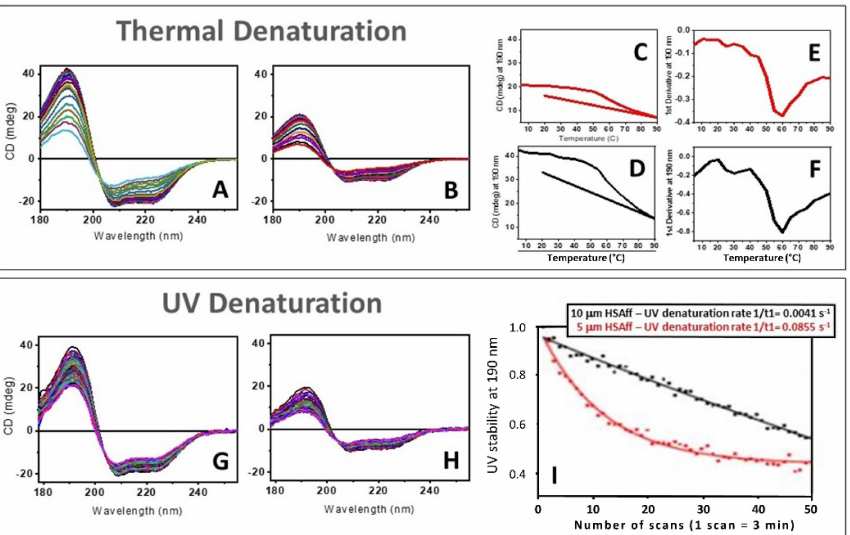
Figure 3. Comparison between thermal and UV denaturation of two solutions of human serum albumin essentially fatty acids and globulin free (HSAff) at different concentrations. ( A , B ) Thermal denaturation experiments: CD spectra of aqueous solutions of 10 µ M and 5 µ M HSAff as a function of temperature from 5 ◦ C to 90 ◦ C at 5 ◦ C interval and back to 20 ◦ C to assess reversibility. ( C , D ) Plots of CD intensity at 190 nm versus temperature and the corresponding first derivative plots ( E , F ). ( G , H ) UV denaturation experiments: SRCD spectra of aqueous solutions of 10 µ M and 5 µ M HSAff as a function of 50 consecutive repeated scans. ( I ) Plot of the normalised SRCD intensity at 190 nm calculated by dividing the value of each scan by that of the first one versus the number scans. The plots represent the rate of protein denaturation by UV irradiation. The experimental data (black squares for HSAff 10 µ M and red squares for HSAff 5 µ M) were fitted with an exponential decay equation [y = y 0 + Ae (-x/t) ] (ExpDec1 fit using Origin suite of programs